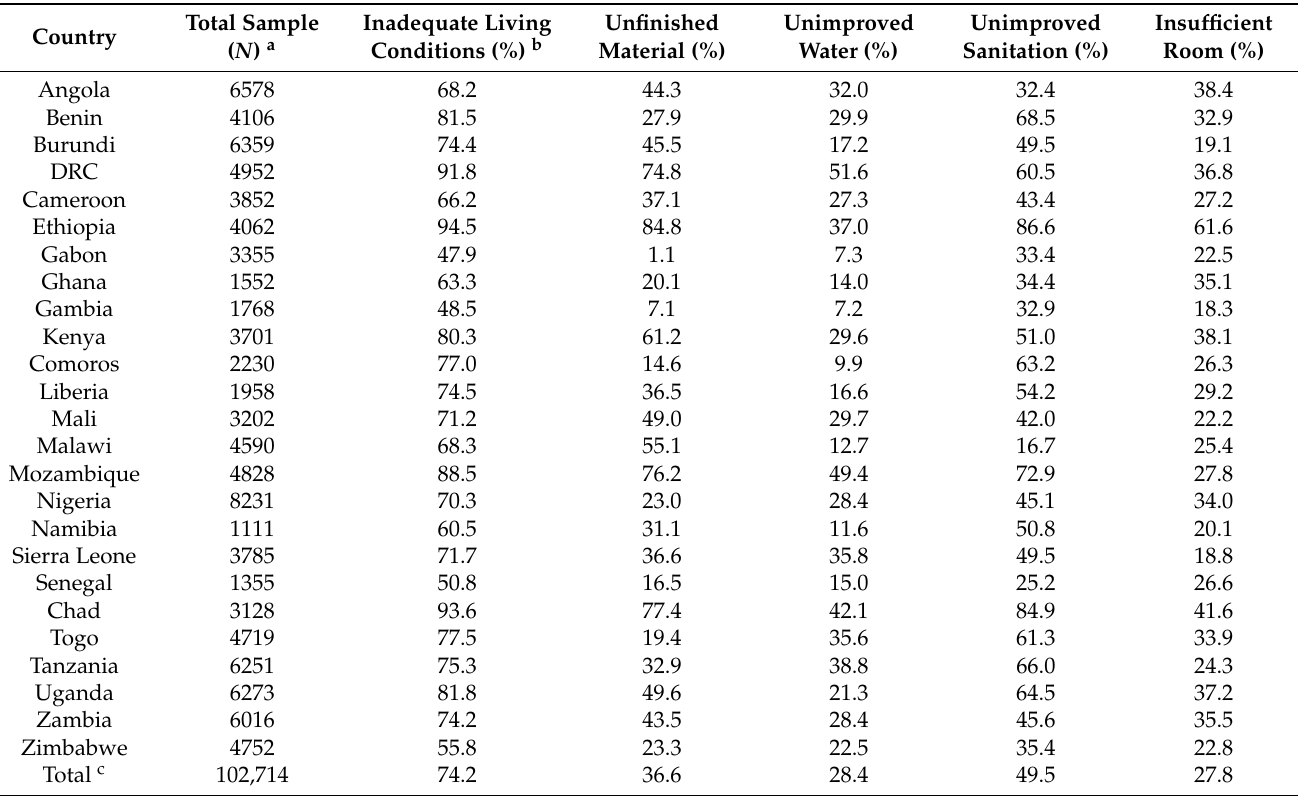
Table 2. Characteristics of living conditions of the study participants.